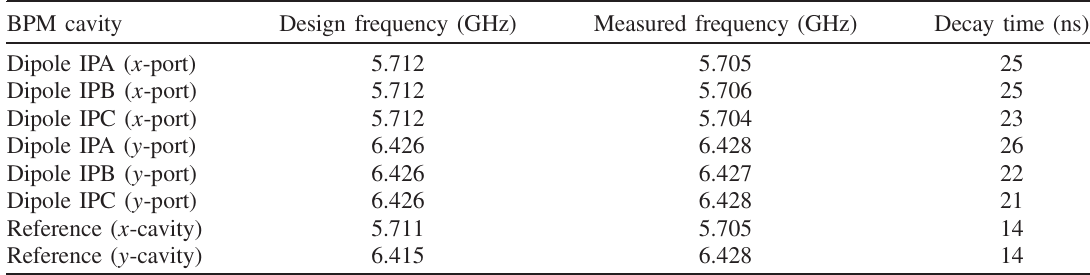
TABLE I. Design and measured values of the resonant frequencies of the dipole [16] and reference [21] cavity BPMs, and measured signal decay times.